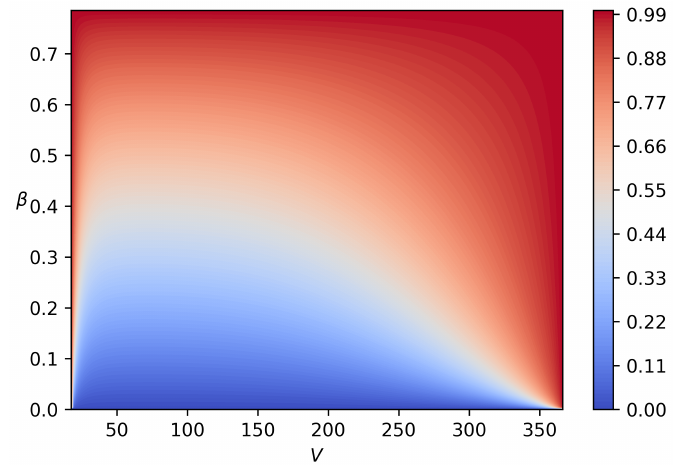
Figure 4. The x axis corresponds to velocity magnitude V and the y axis to velocity angle β . Nozzle contours are computed from the solution by integrating Equation (10) along the right, upper and left boundaries (where ψ = 1) with the second order explicit Runge–Kutta method. Serial computations show that 200 nodes along each direction are sufficient to obtain the mesh independent solution.